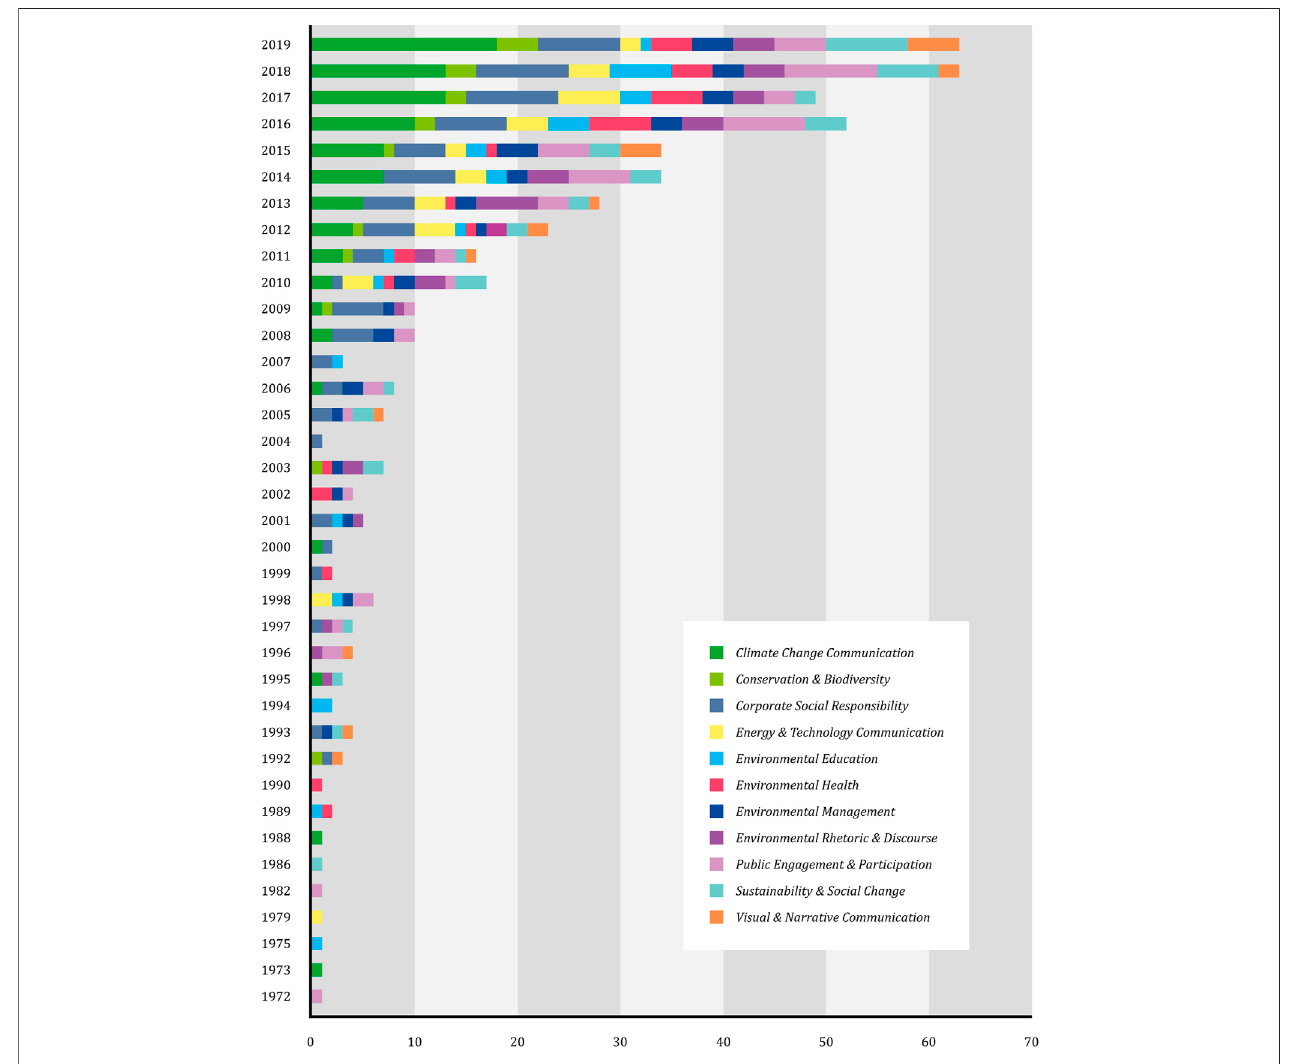
FIGURE 7 | Number of abstracts with each primary theme by year, 1970 – 2019 ( n (cid:1) 474).